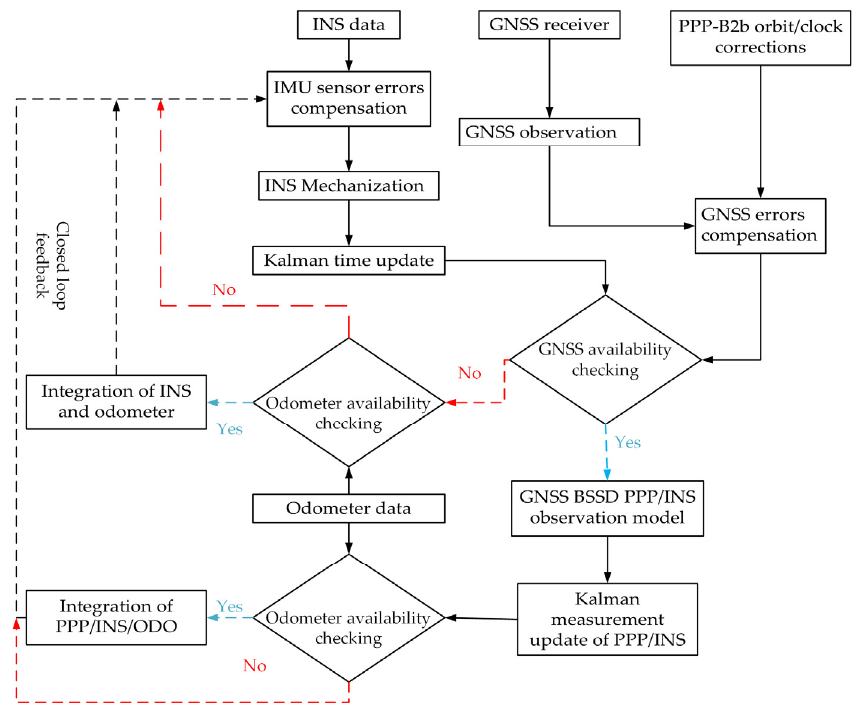
Figure 1. Algorithm of BSSD PPP/INS/ODO TCI structure.